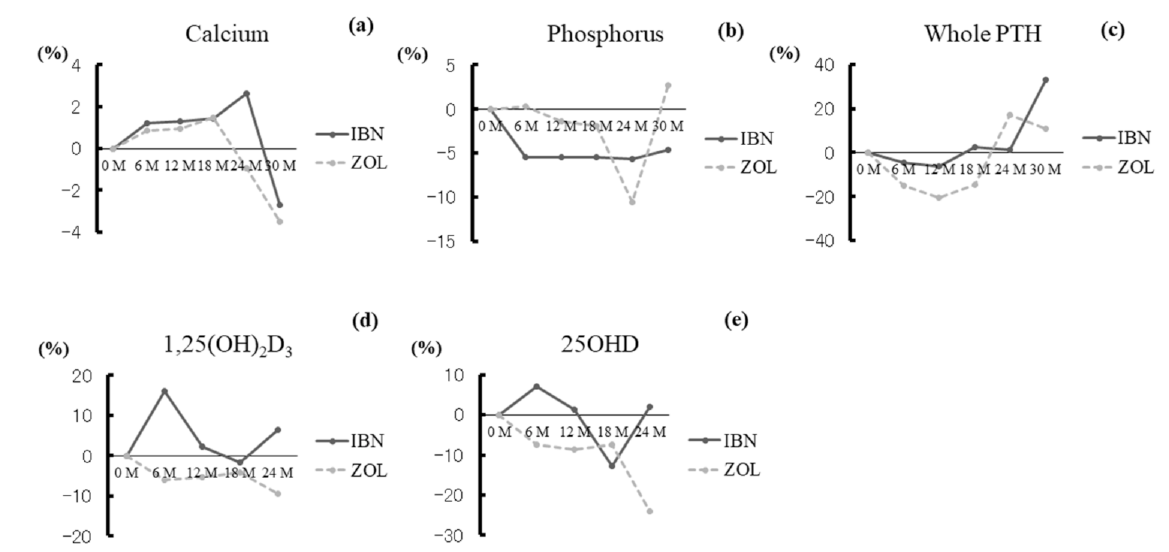
Figure 2. Percentage changes of serum albumin-corrected calcium ( a ), phosphorus ( b ), whole PTH ( c ), 1,25(OH) 2 D 3 ( d ), and 25OHD ( e ). ( a – e ) Serum albumin-corrected calcium, phosphorus, whole PTH, 1,25(OH) 2 D 3 , and 25OHD levels did not change significantly versus baseline values in either the IBN group or the ZOL group at any time point.